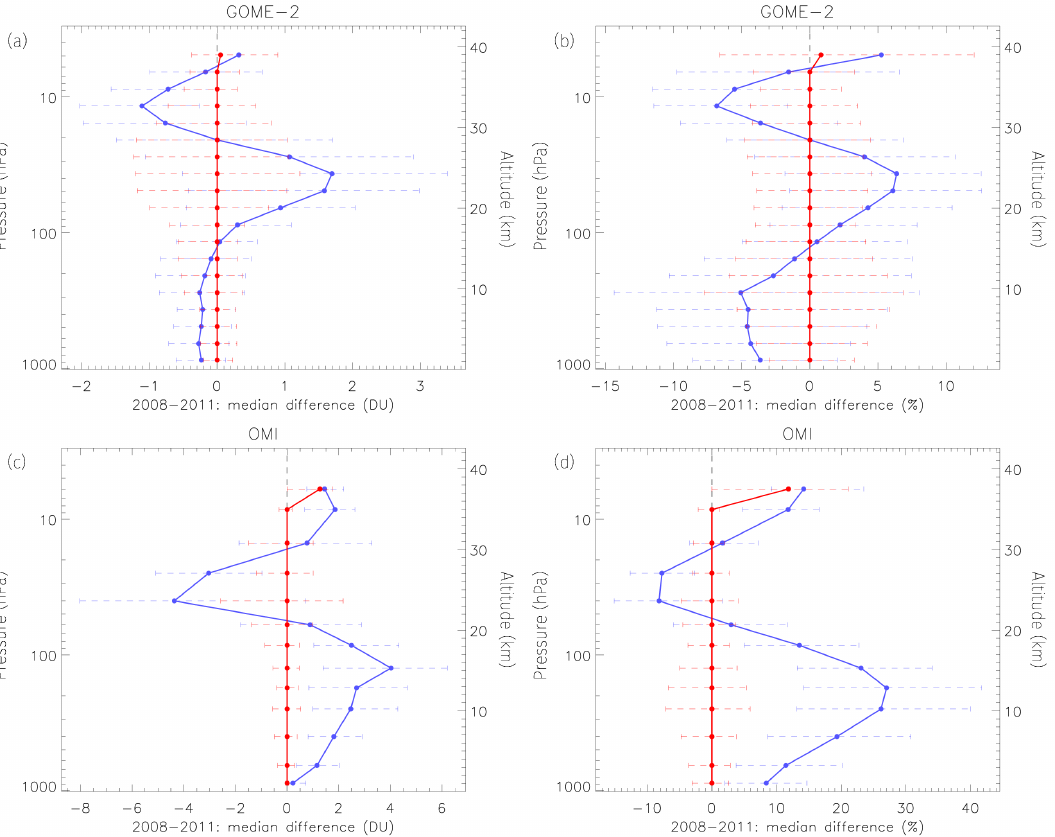
Figure 6. Global validation results for 2008–2011 for GOME-2 (a, b) and OMI (c, d) . (a, c) show the median absolute differences, (b, d) show the median relative differences. The blue line indicates the original observations, the red line the bias corrected observations that have been used as input for the assimilation. The error bars indicate the range between the 25 and 75% percentiles. Note that the x axis scale is different for each